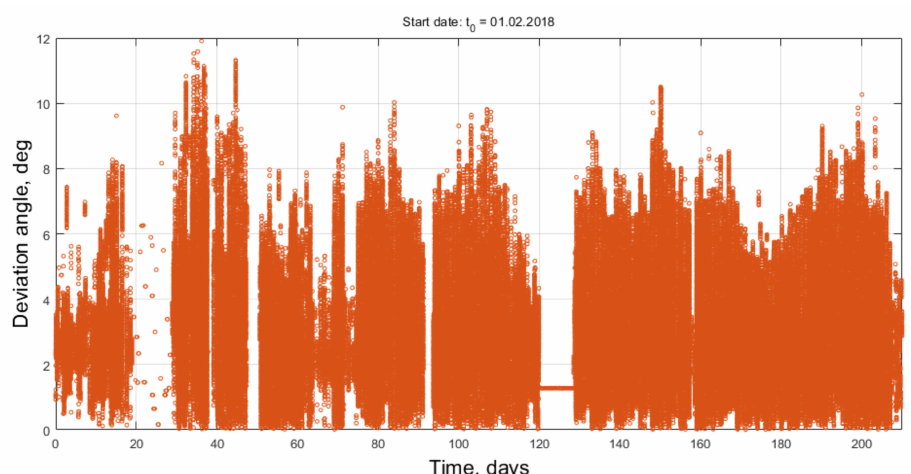
Figure 11. Deviation of OZ axis from the direction of the local magnetic field for 210 days starting from 1 February